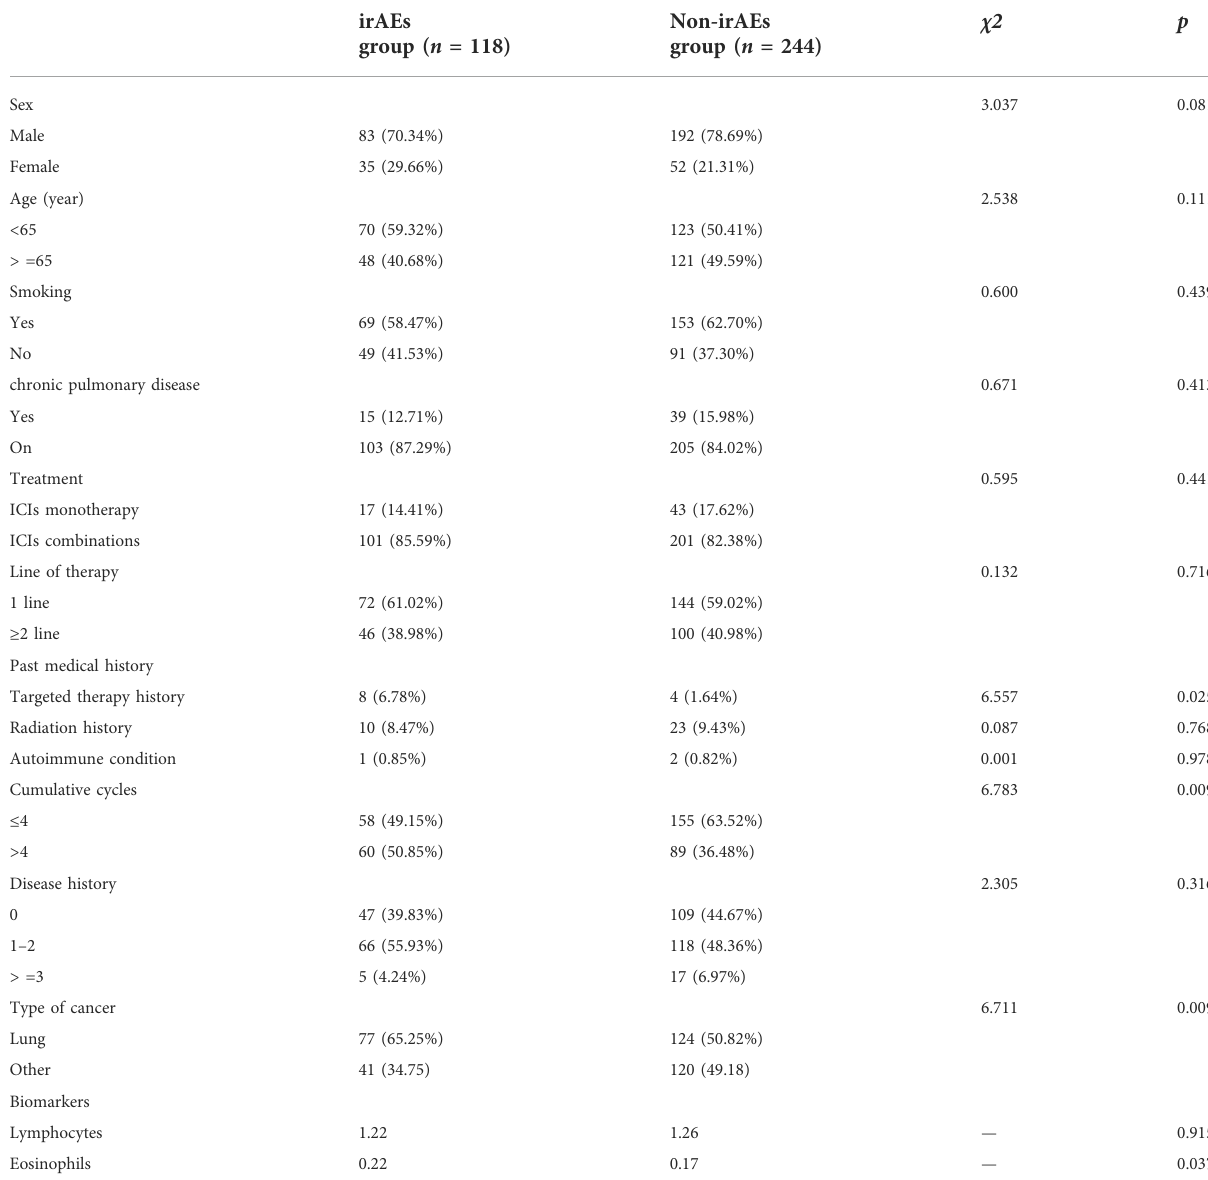
TABLE 3 Risk factors for irAEs with univariate analysis.